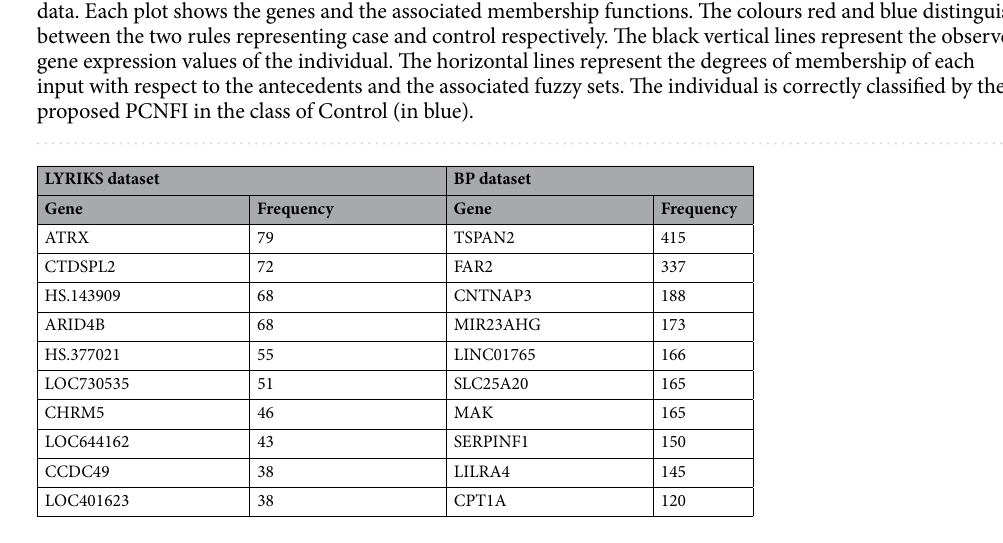
Table 4. The frequency of genes being selected among the top 10 genes for LYRIKS and top 6 genes for BIPOLAR (selected by SNR) for every individual neighbourhood in the LYRIKS and Bipolar dataset. We created a total number of 84 personalised models for the 84 samples in LYRIKS datasets and 476 Personalised models for the 476 samples in bipolar dataset.